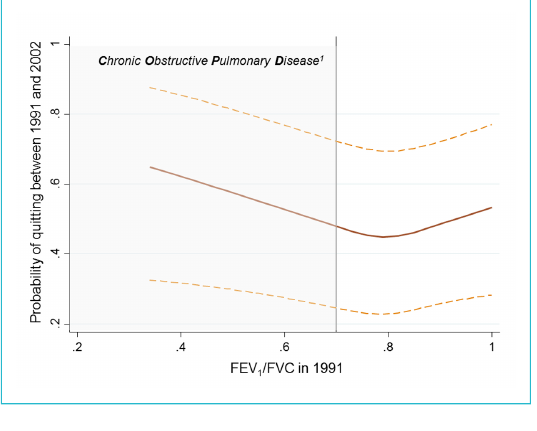
Figure 1: Estimated probability of quitting smoking between 1991 and 2002 as a function of FEV1/FVC in 1991, with 95% confidence limits*. 1 Defined according to the GOLD report definition*derived from a logistic regression model of smoking cessation between 1991 and 2002 containing a natural cubic spline function of base- line FEV1/FVC and adjusting for age, sex, study area, civil status, educational level, nationality, BMI, parental smoking, exposure to environmental tobacco smoke, number of cigarettes smoked per day and presence of respiratory conditions (chronic cough, chronic phlegm and asthma) at baseline